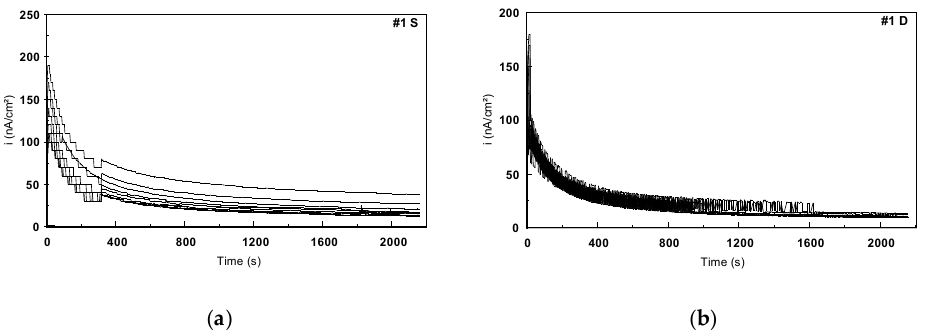
Figure 21. Potentiostatic curves recorded for the level of 600 mV/SCE for #1 in 9 g/L NaCl corresponding to ( a ) static and ( b ) dynamic mechanical cycles.